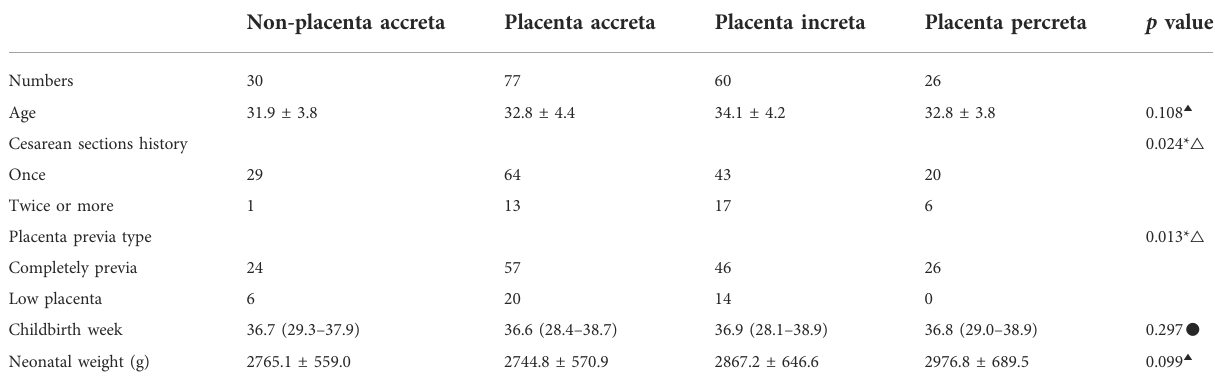
TABLE 2 Patient general characteristics.